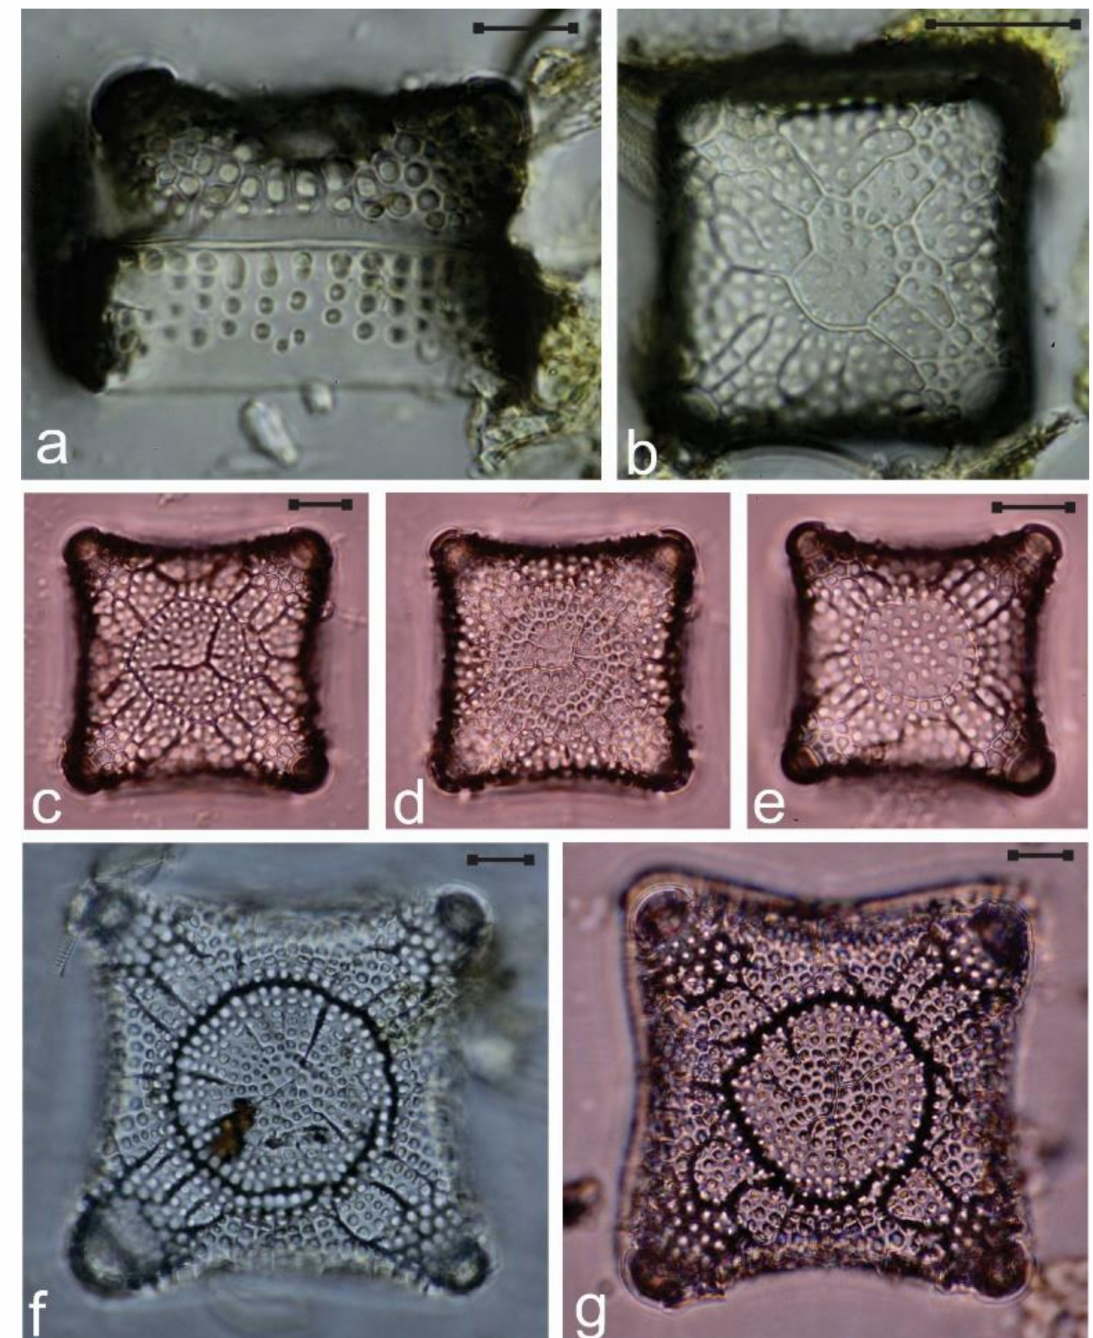
Figure 15. ( a , b ) Amphitetras antediluviana mantle view of valve with barely raised elevations; ( c – g ) Triceratium balearicum fo. biquadrate valve with four slightly raised elevations. Scale bar = 10 µ